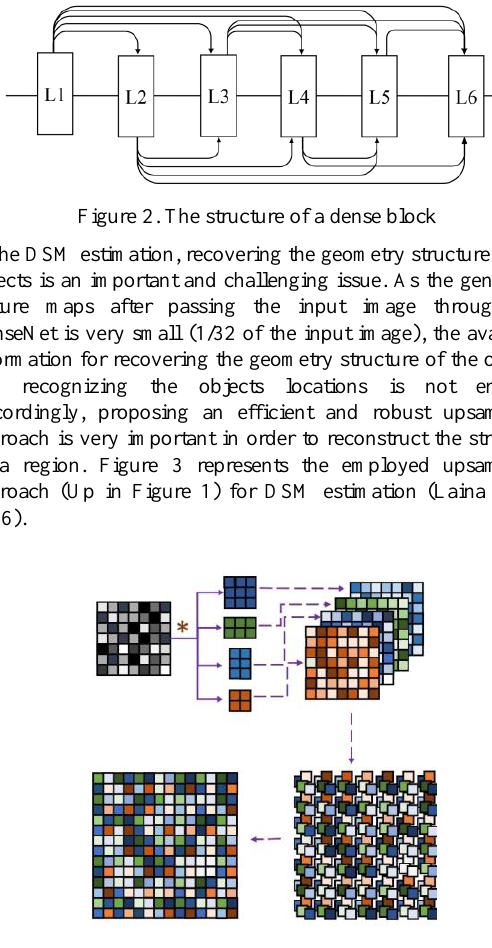
Figure 3. The structure of upsampling